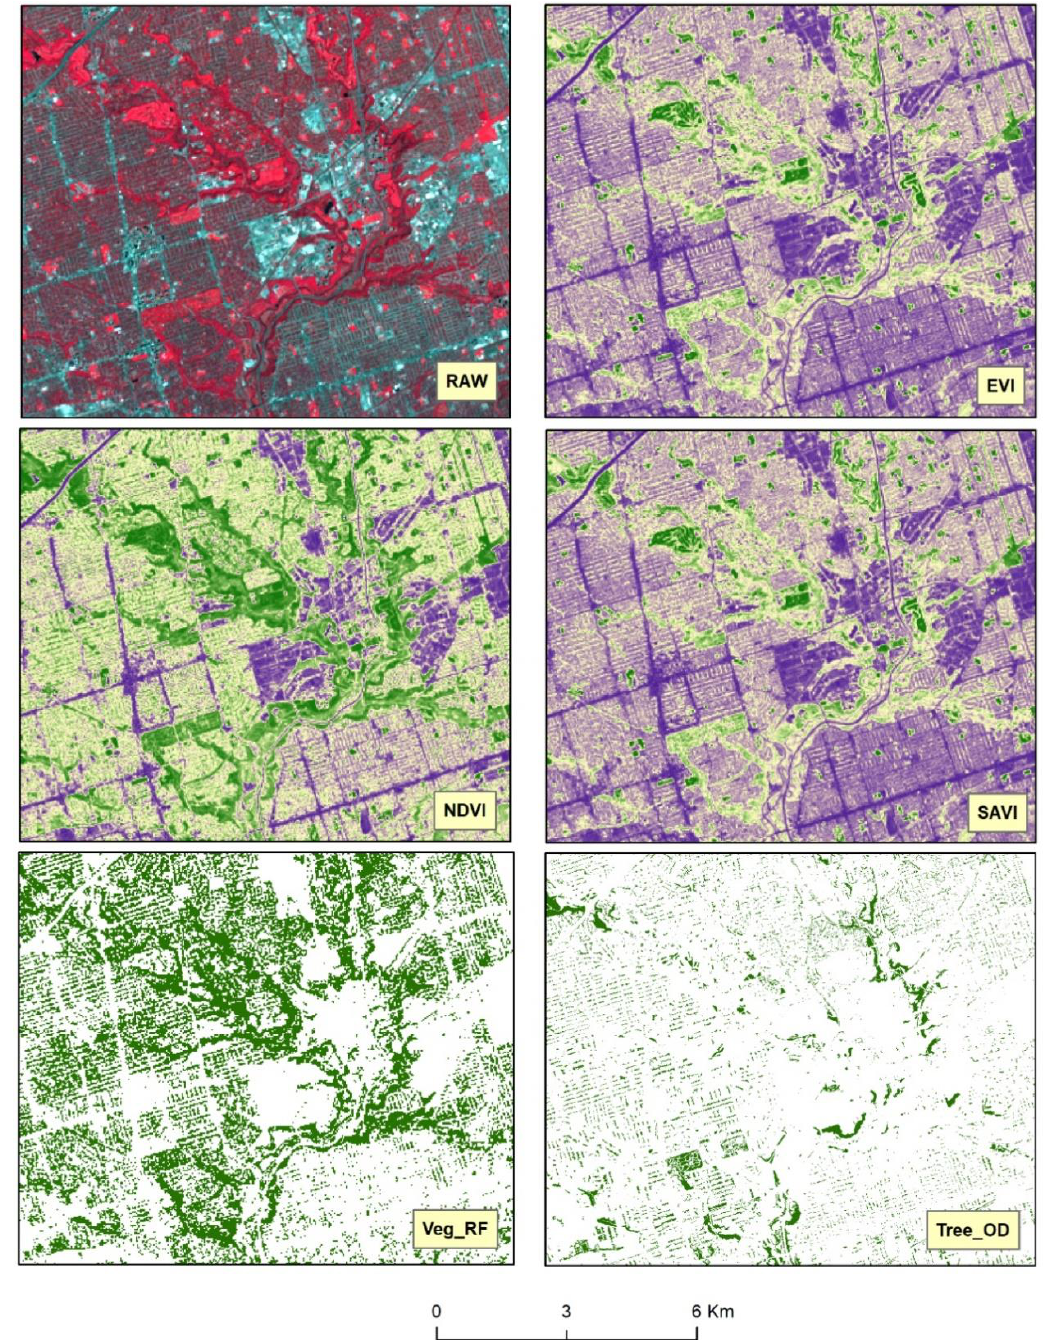
Figure 3. The micro-scale differences between the three vegetation indices and the area-based measures of vegetation cover. The shades of green represent the vegetation-covered areas for all the three vegetation indices, with darker shades of green representing dense and healthy vegetation. The yellow and the purple areas mainly represent the non-vegetation areas in the indices. The solid green color represents vegetation cover, while the white color represents non-vegetation regions in the area-based measures.